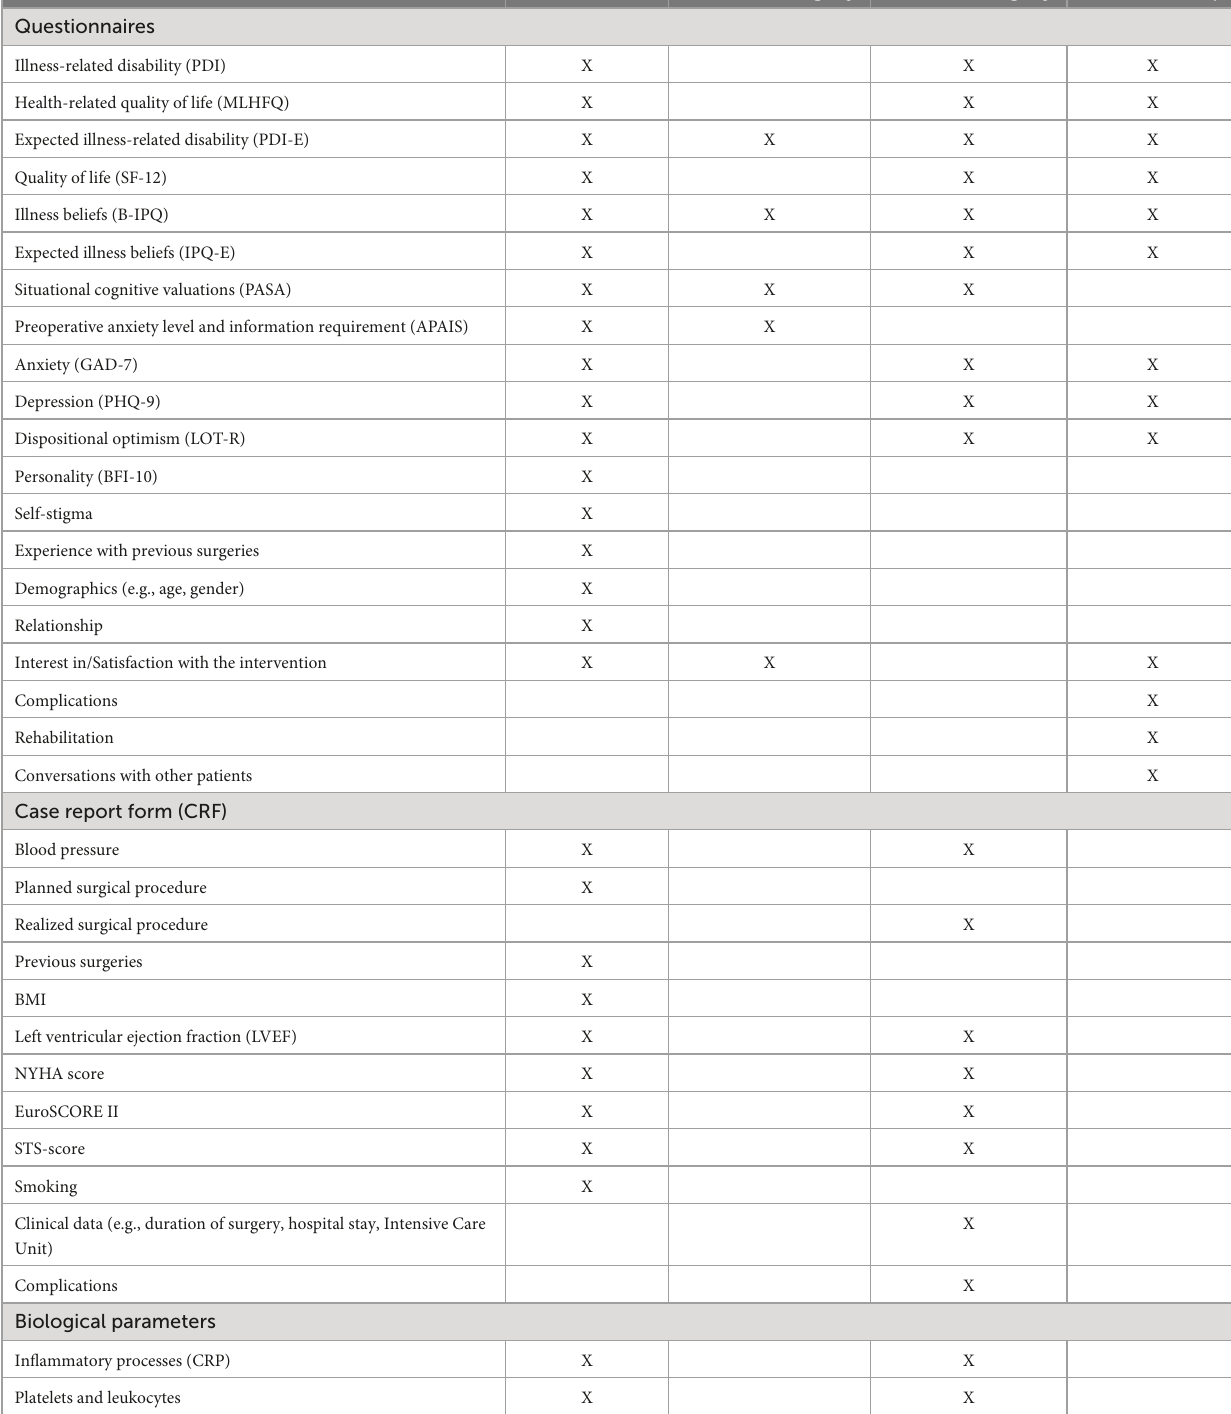
TABLE 2 Overview of assessment. Measurement T0a: Baseline T0b: Pre-surgery T1: Post-surgery T2: